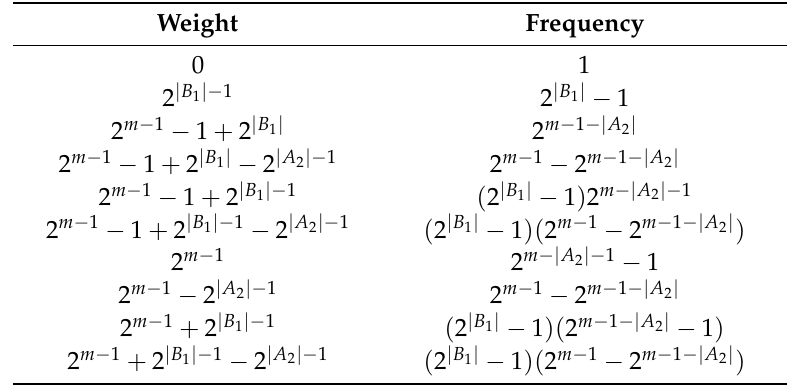
Table 3. Weight distribution of the code in Theorem 1 (2b).